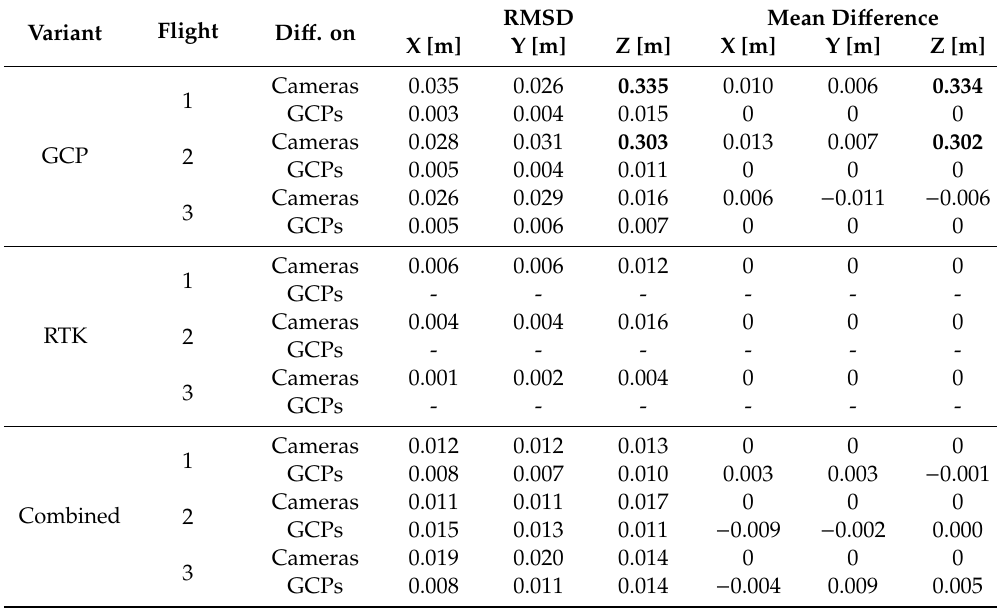
Table 6. Results for the Rural area—RMSDs and mean di ff